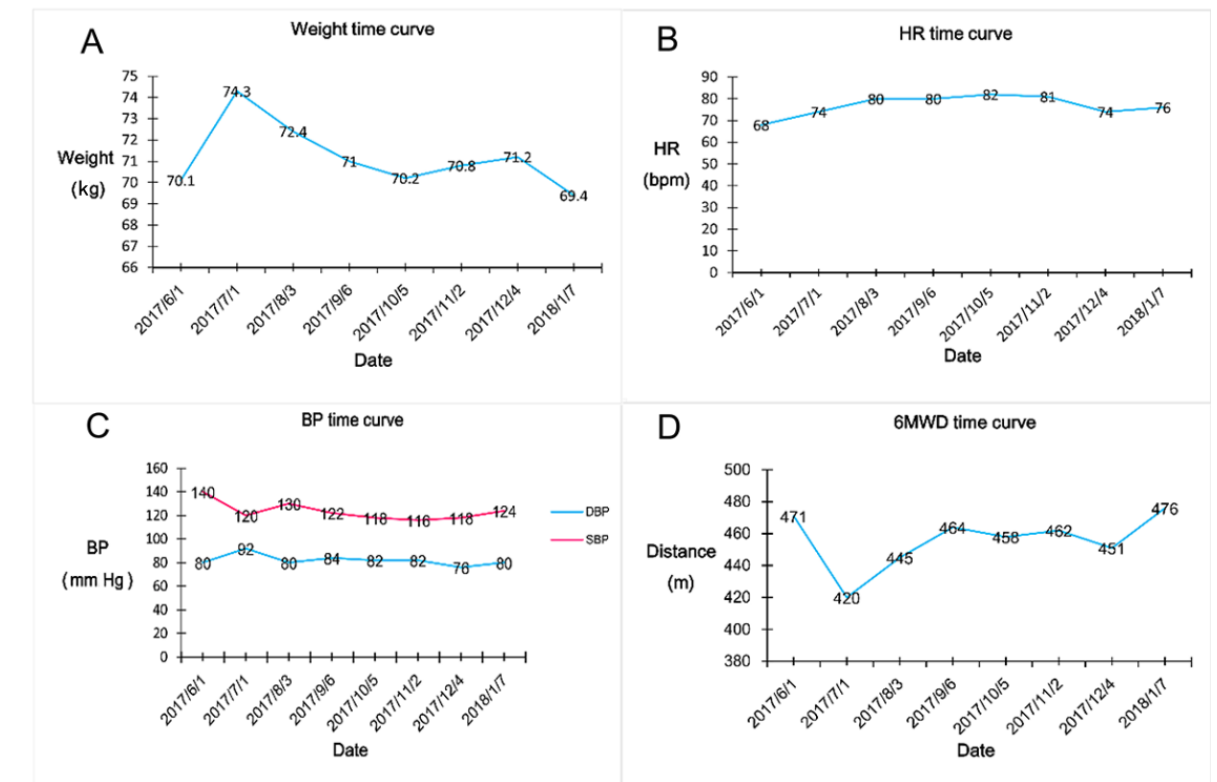
Figure 5. Data trends of a person on the remote monitoring service platform. HR: heart rate; BP: blood pressure; DBP: diastolic blood pressure; SBP: systolic blood pressure; 6MWD: 6-min walk distance.